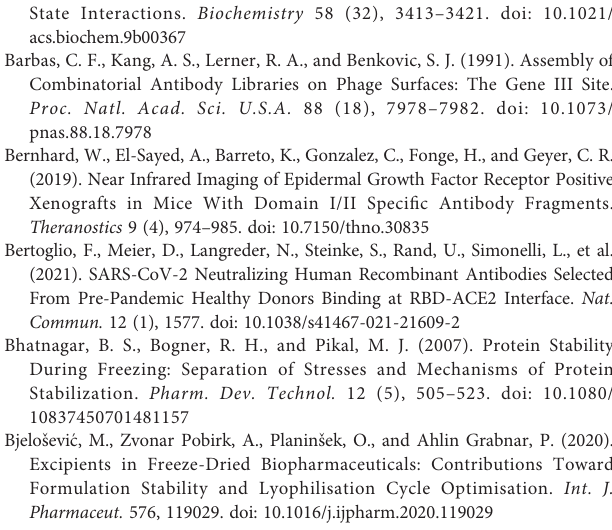
Supplementary Figure 1 | Different glass vials size lyophilization comparison test. (A) Cake appearance immediately post lyophilization or after 30 days RT storageof315µL0.5mg/mLTUN219-2C1-hFcAbsolutioninacylindricalglassvial having abase-diameter of 15 mm and (C) 189 µL of the same materialin a glass vial